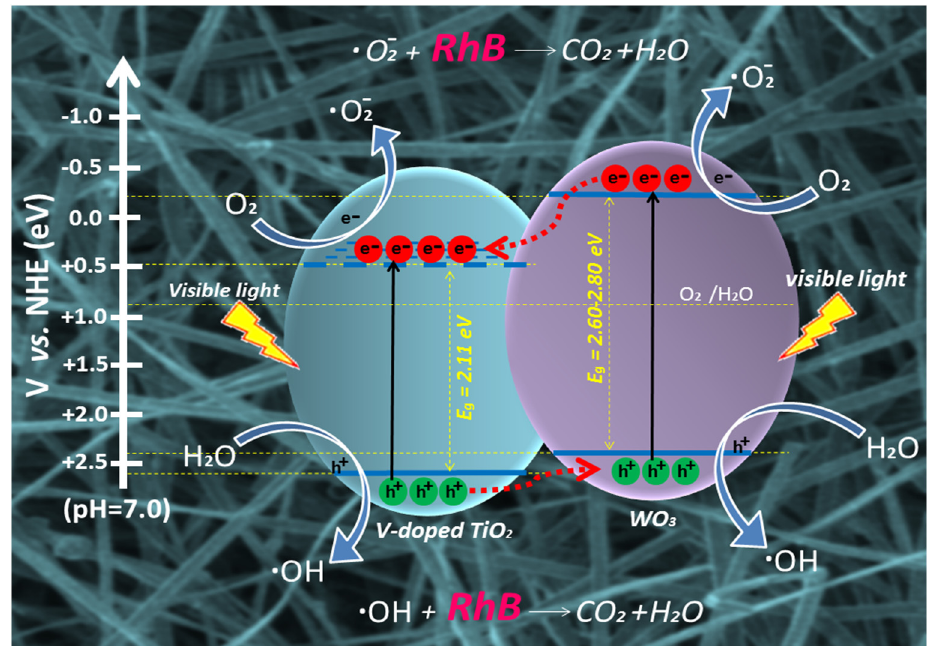
Figure 10. Possible photocatalytic mechanism for the RhB degradation in water, using the TWV5-loaded fibers nanocomposites.